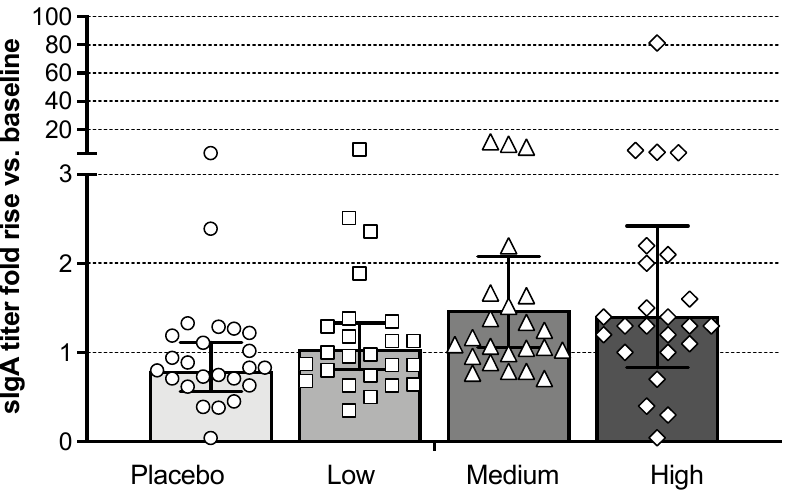
Figure 4. Influenza A/Brisbane/10/2007 HA-specific secretory IgA (sIgA) responses in nasal swabs. Shown are fold increase in HA-specific sIgA titer normalized to total IgA on day 28 post-vaccination over baseline. Bars represent the geometric mean ELISA titer with error bars showing the 95% confidence interval. Each symbol represents an individual